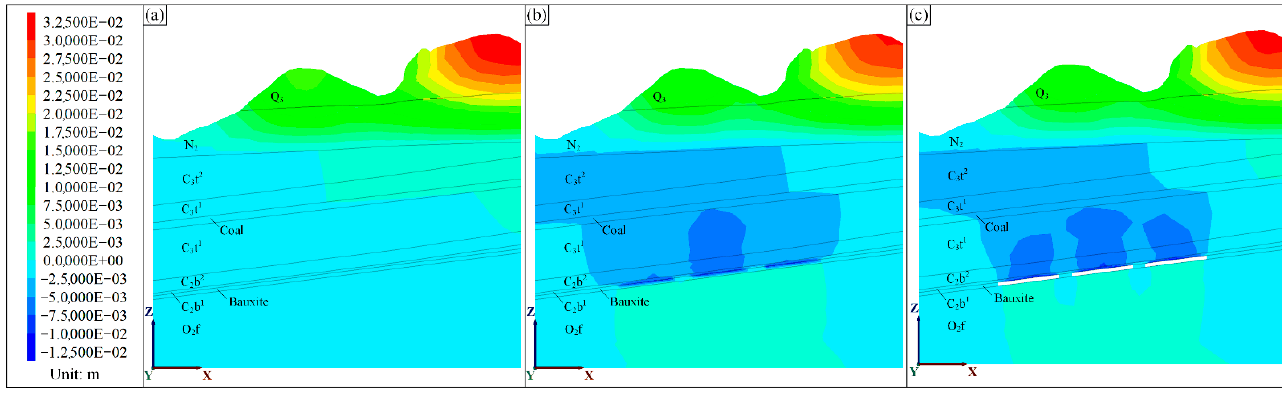
Figure 8. Distribution of Z-direction displacement: ( a ) non-mining condition; ( b ) normal backfilling condition; ( c ) non- backfilling condition.